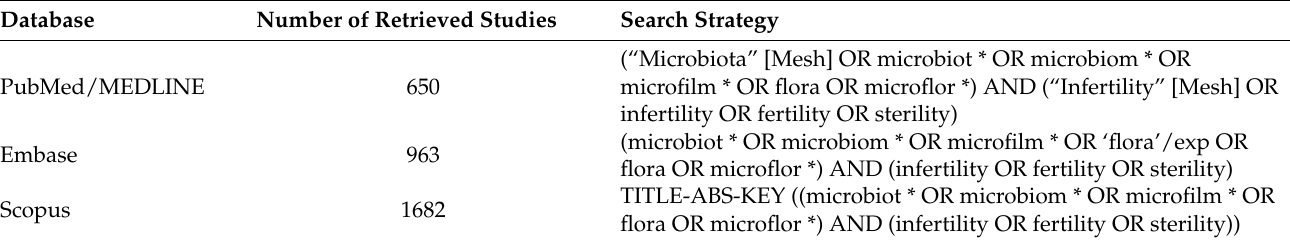
Table 1. Search strategy for used